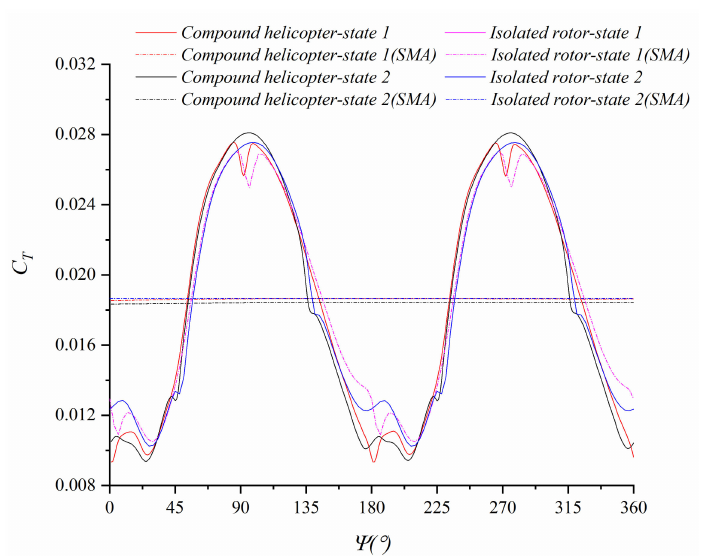
Figure 28. The wing C T in forward flight.